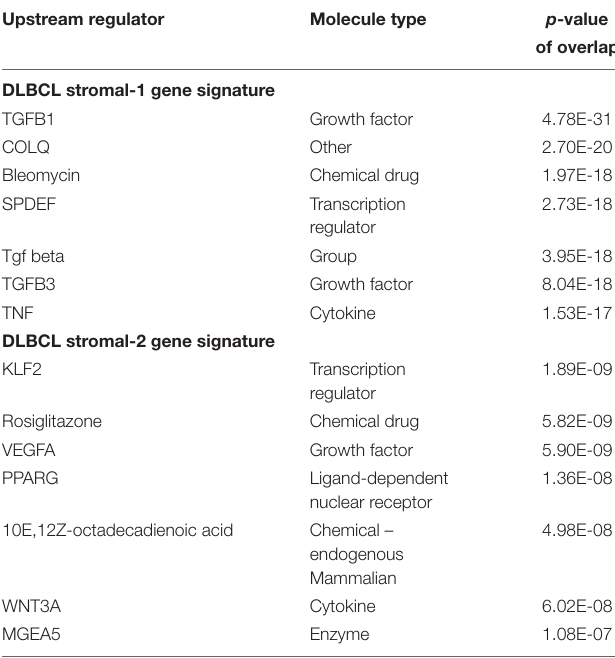
TABLE 2 | Upstream regulators of genes in the DLBCL stromal gene signature-1 and stromal gene signature-2. Upstream